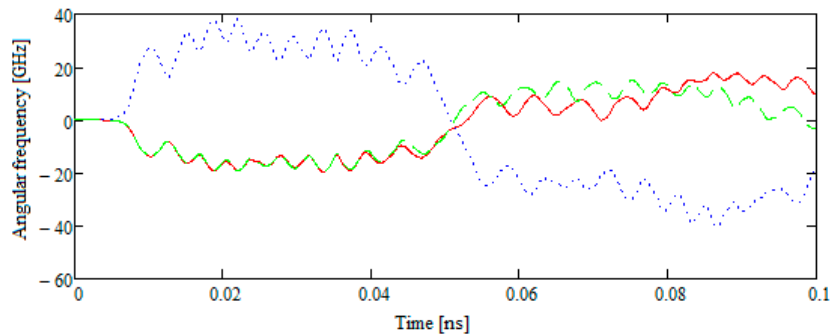
Figure 6. Angular frequency of these disks.